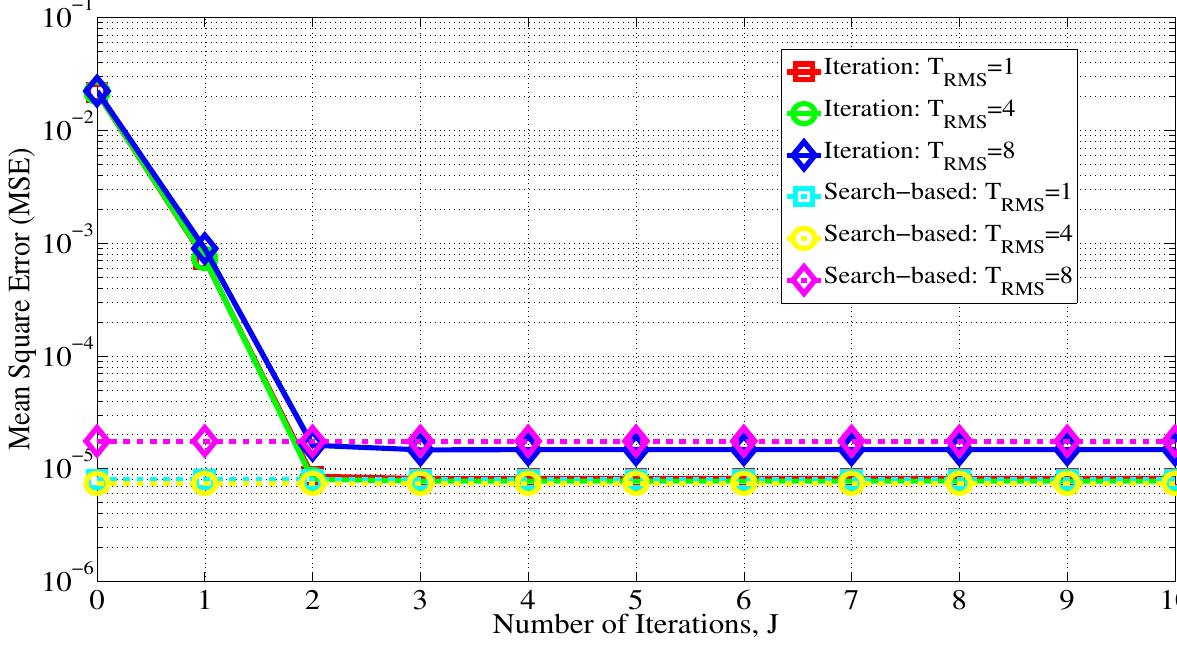
Figure 3. Convergence behavior of the proposed iterative CFO estimation for different RMSs of channel delay spread, τ . N = 256, K = 64, SNR = 30 dB and (cid:15)